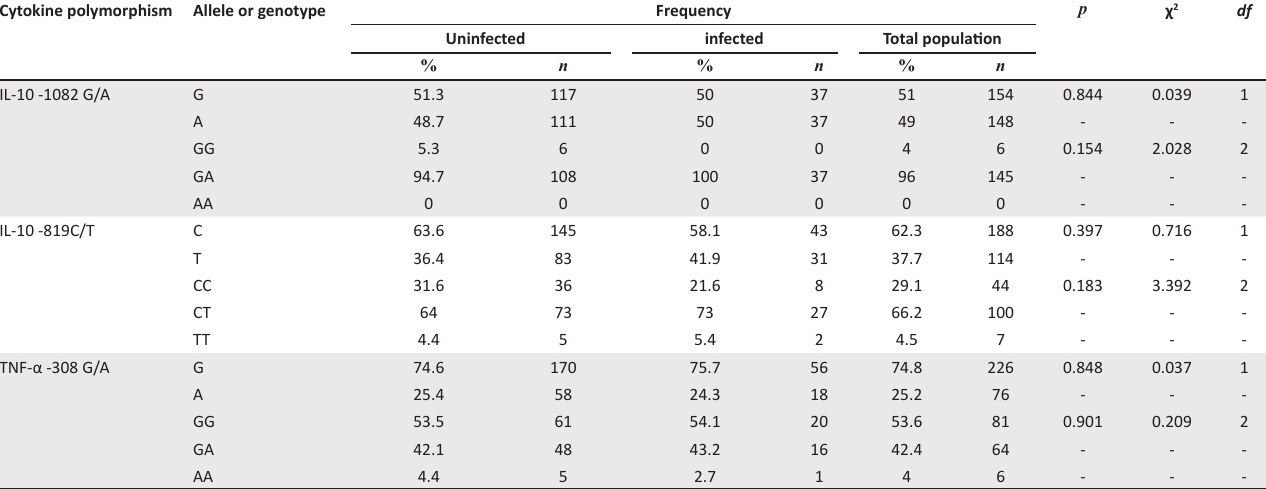
TABLE 4: Distribution of the interleukin-10 -1082, interleukin-10 819 and tumour necrosis factor alpha genotypes and alleles frequencies in uninfected and infected Schistosoma haematobium groups in Bandanyenje. Cytokine polymorphism Allele or genotype Frequency